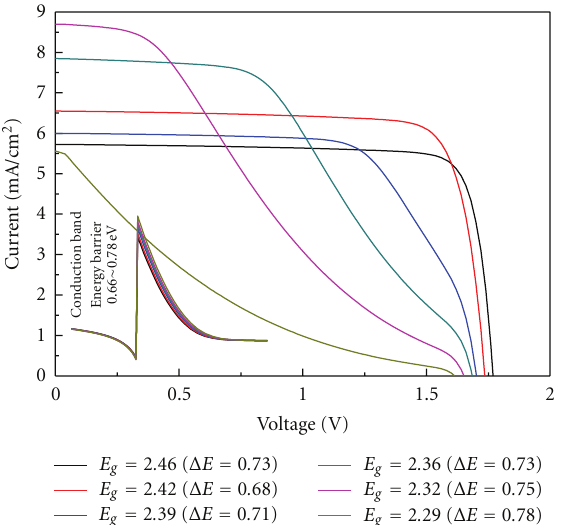
Figure 4: The current-voltage ( I - V ) curve of pin solar cells with various In x Ga 1 − x N energy bandgaps (corresponding to an In composition of 0.25–0.3 in Figure 2).